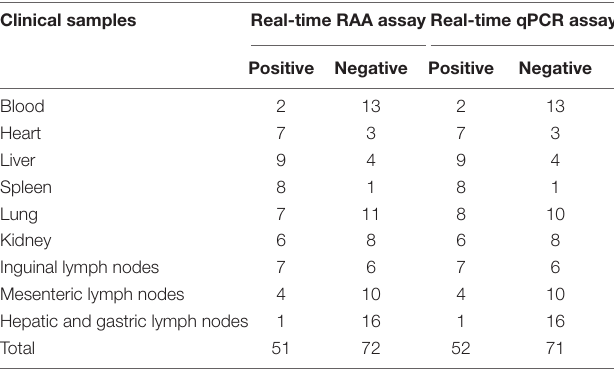
TABLE 6 | Comparison of the real-time recombinase-aid amplification (RAA) assay with the real-time quantitative PCR (qPCR) assay on clinical samples. Clinical